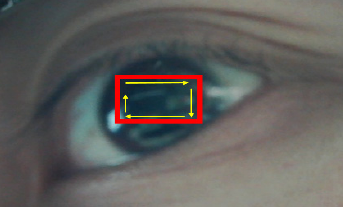
Figure 12. Diagram of tracking pupil’s center with the nearfield eye camera for calibration. In Figure 12, the yellow line indicates the sequence of the movement path of gazing markers, and the red rectangle indicates the range of the eye movement. In Figure 13, when the calibration process is executed, the user gazes at the four markers sequentially from ID 1, ID 2, ID 3, to ID 4, and the system records the coordinates of the pupil movement path while watching the gazing coordinates of the outward scene with markers. Then, the proposed system performs the coordinate conversion to achieve the calibration effect.